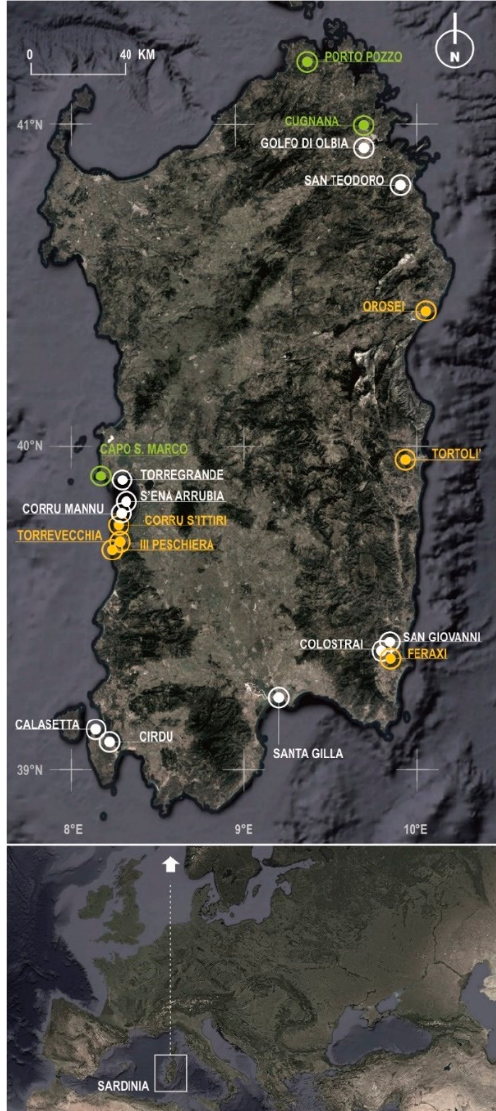
Figure 1. The geographical location of the study site with the 19 production areas. Yellow and green circles indicate where DSP and PSP were detected, respectively.